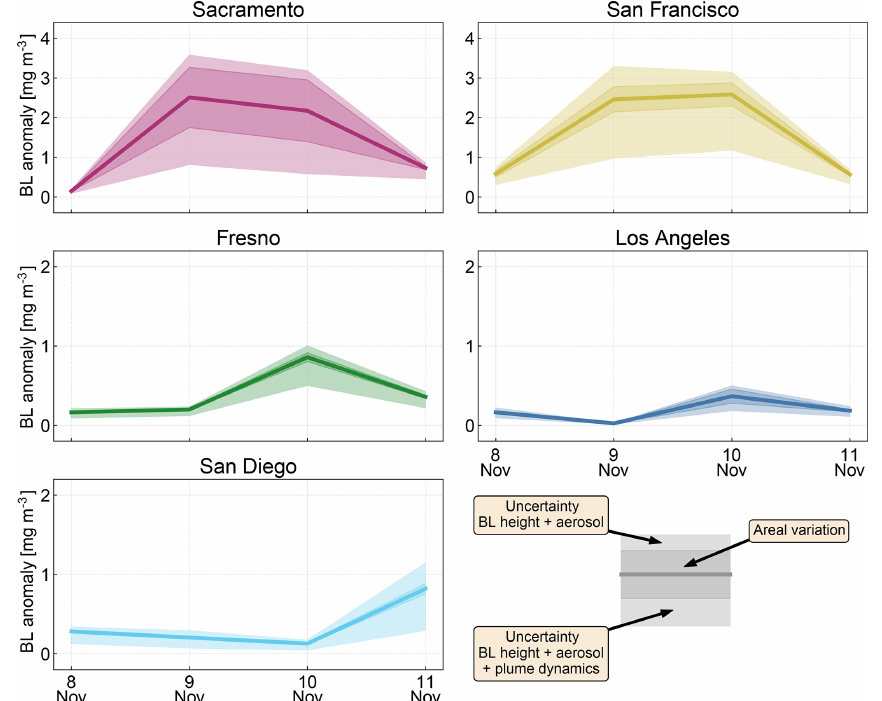
Figure 10. Averaged boundary layer concentration anomalies of CO (relative to 7 November) and associated areal variations and uncertainties (1 σ ) in major Californian cities during the first days of the Camp and Woolsey